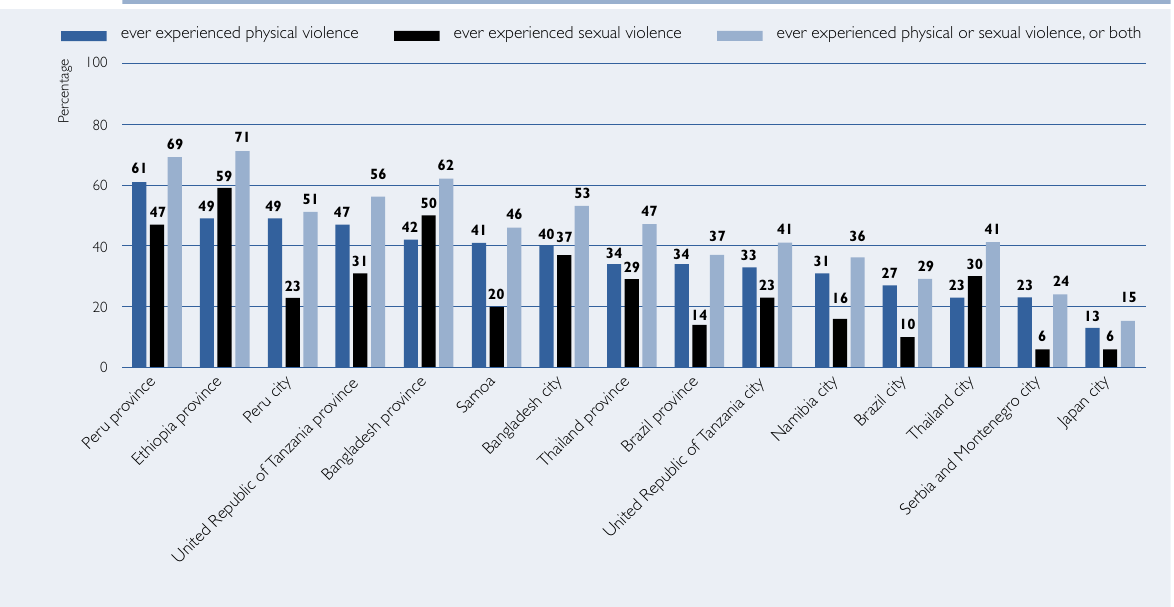
Figure 2 Prevalence of lifetime physical violence and sexual violence by an intimate partner, among ever-partnered women, by